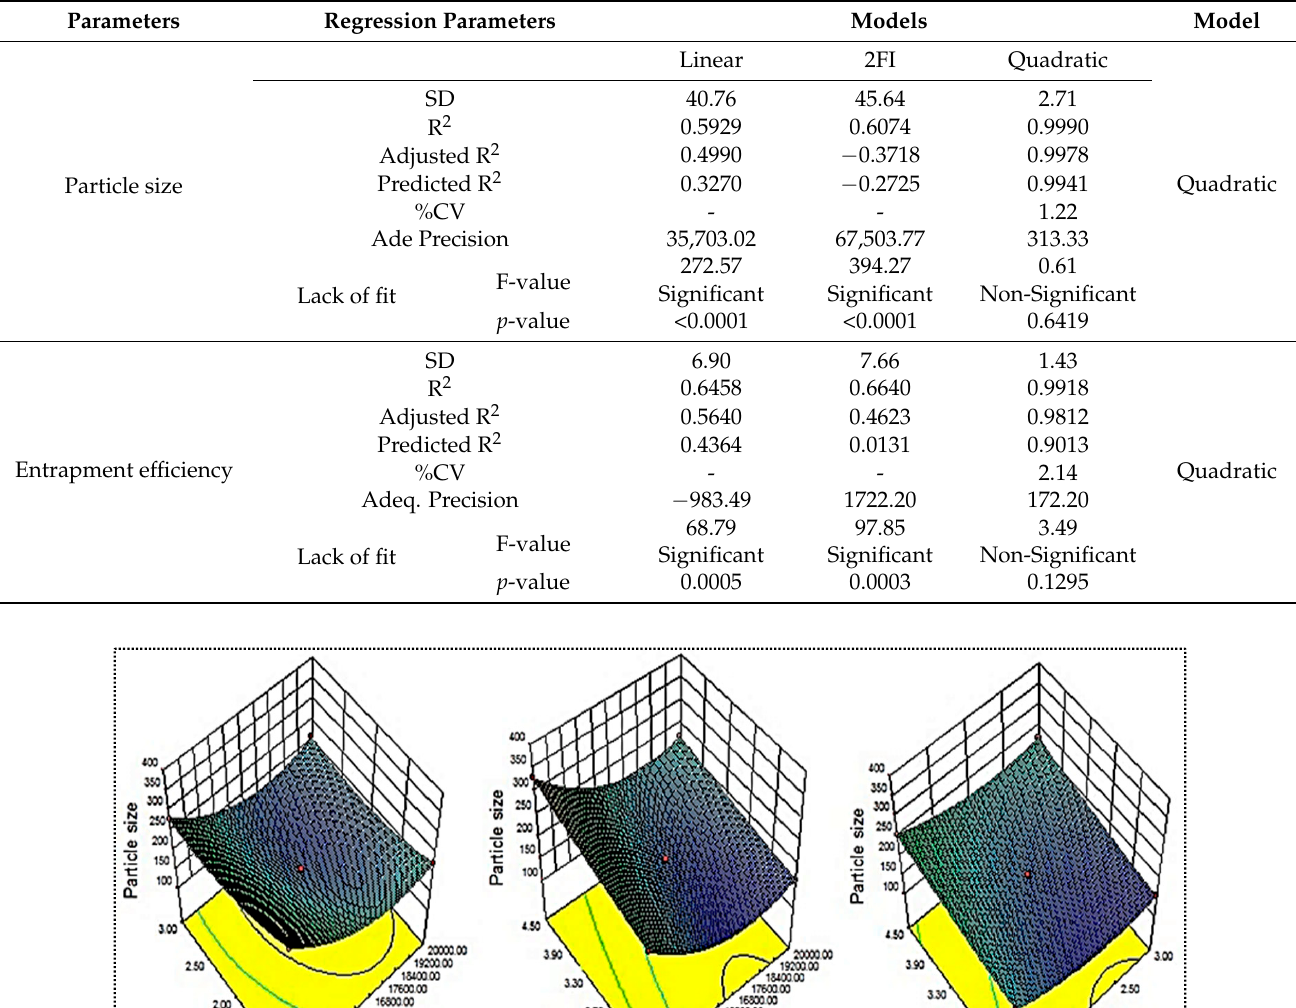
Table 2. Statistical model fit summary report.